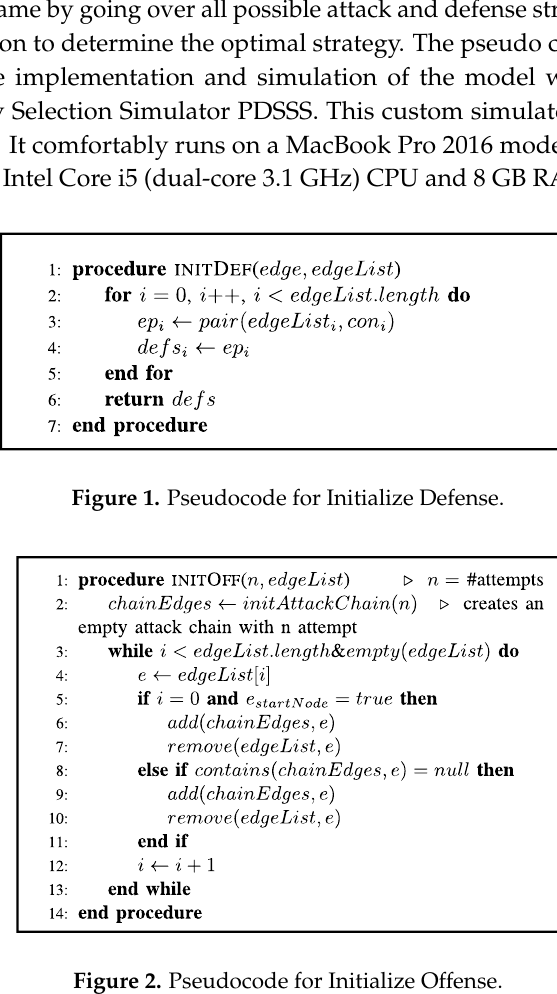
Figure 3. Pseudocode for game